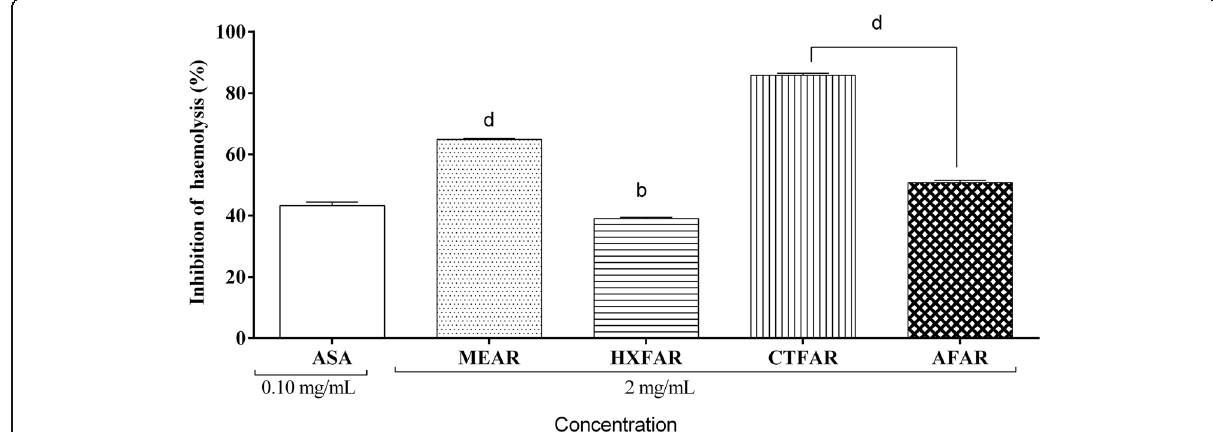
Fig. 2 Effect of different extracts of stem of Albizia richardiana on heat induced haemolysis of erythrocyte membrane. Values are represented in Mean ± SEM (n = 3). d P < 0.0001 and b P < 0.01 considered as statistically significant in comparison to positive control acetylsalicylic acid